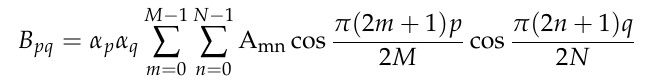
11 , F 12 , F 21 } defined in